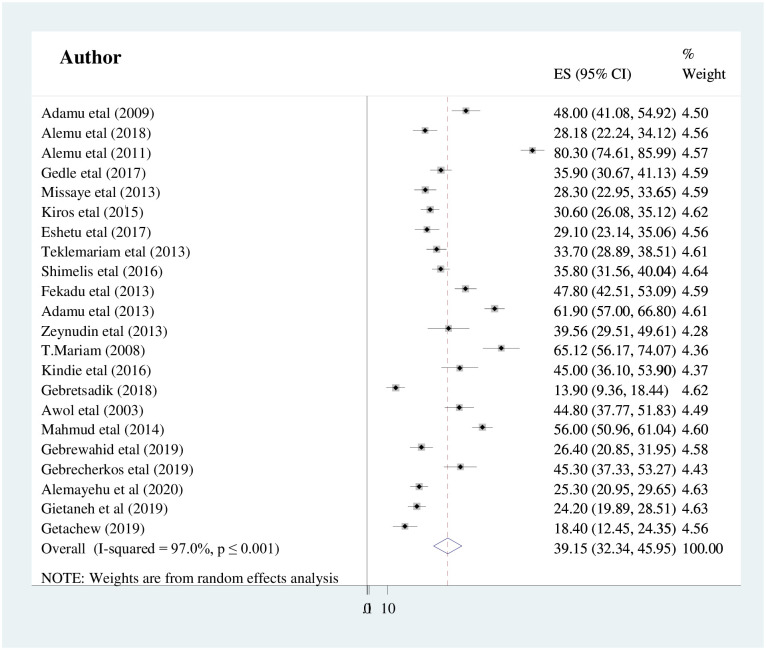
Forest plot showing the pooled prevalence of intestinal parasitic infection among people living with HIV/AIDS in Ethiopia.